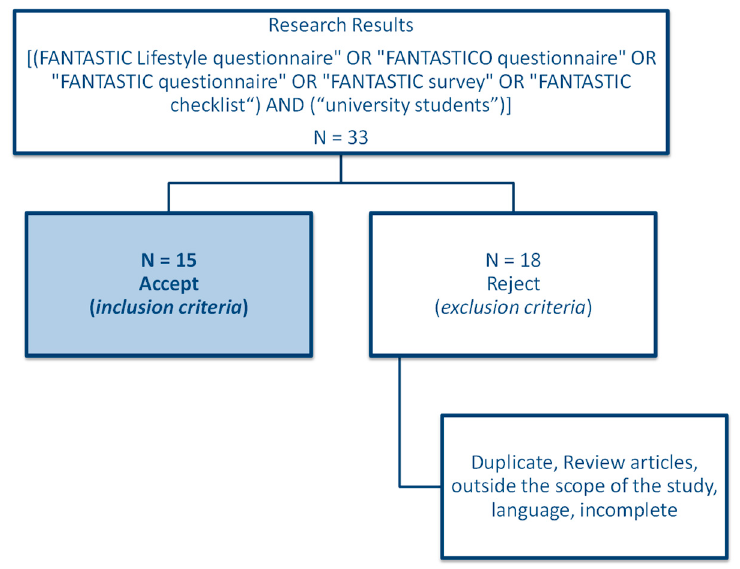
Figure 1. Flowchart applying the inclusion and exclusion criteria in research.